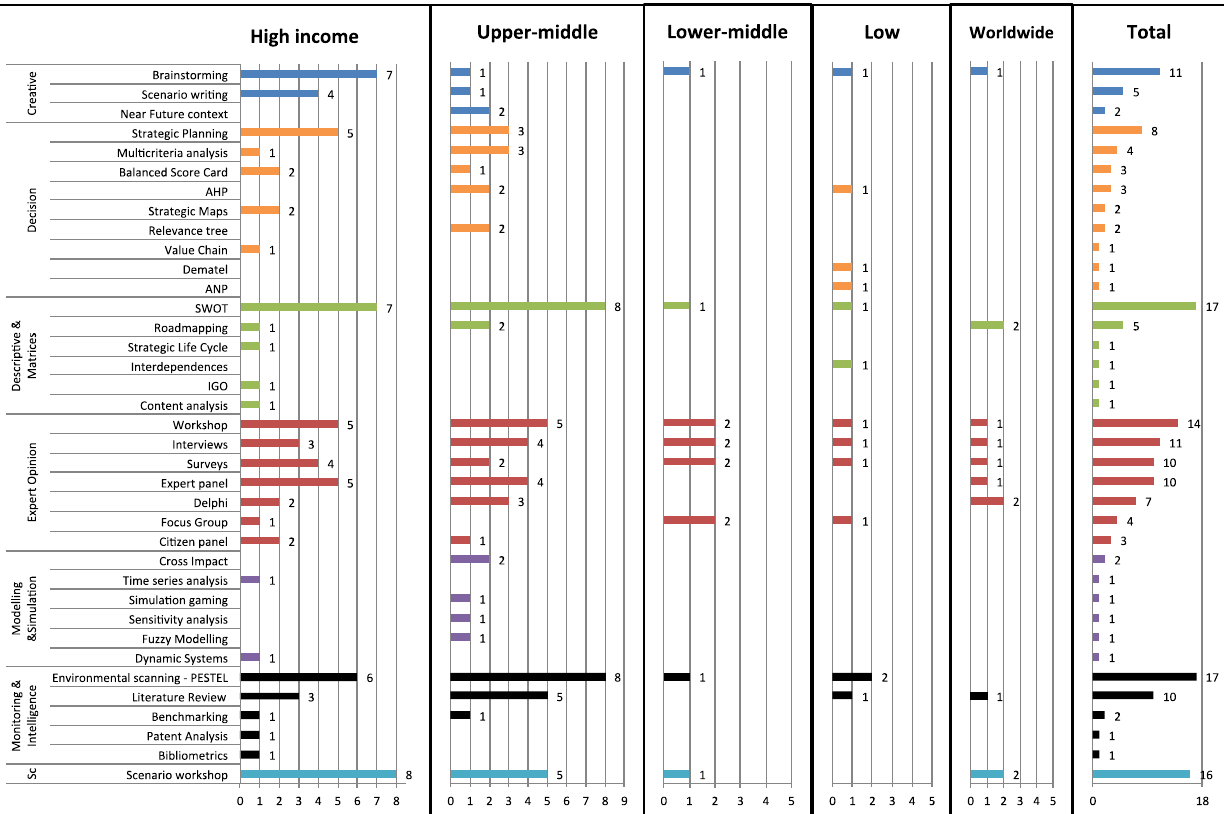
Fig. 3 Families of methods of FTA related to country income level